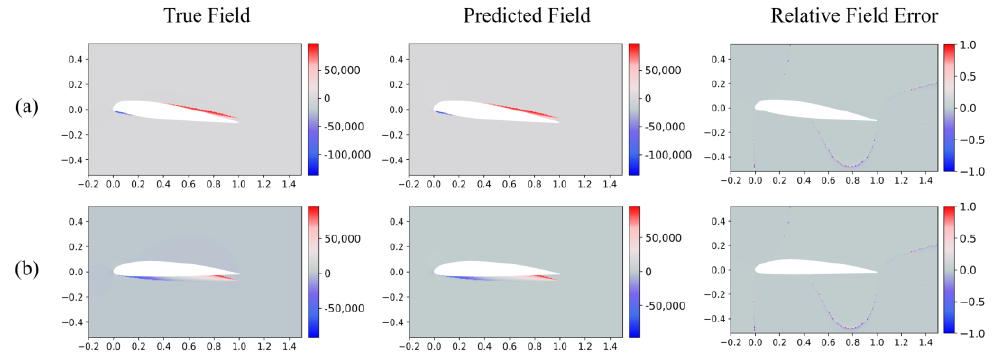
Figure 11. The true (CFD) and predicted velocity gradient fields for three airfoils under Re = 7 × 10 6 : ( a ) NACA3112 with 6° AOA and ( b ) NACA3312 with 1° AOA.